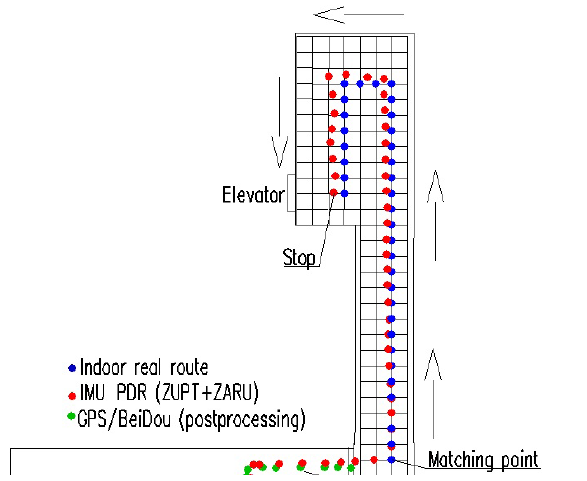
Figure 7. The positioning results of IMU PDR using ZUPT + ZARU corrections (indoor